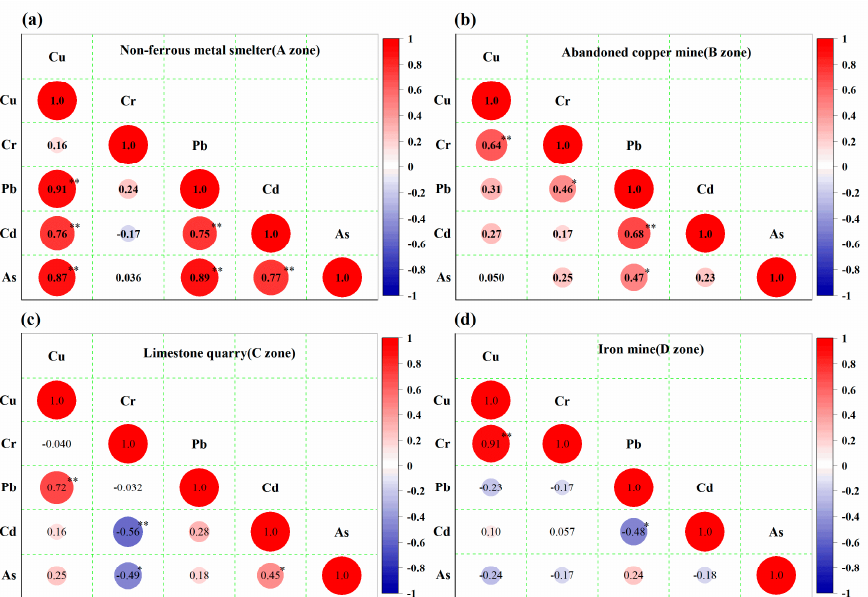
Figure 5. Correlation plots of heavy metals in the four zones: ( a ) Non-ferrous metals smelter; ( b ) Abandoned copper mine; ( c ) Limestone quarry; ( d ) Iron mine; * p < 0.05, ** p <